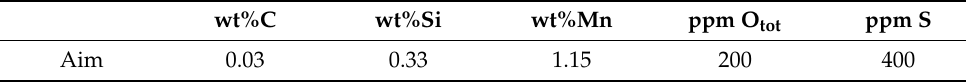
Table 1. Aimed steel composition at deoxidation, for laboratory trial.